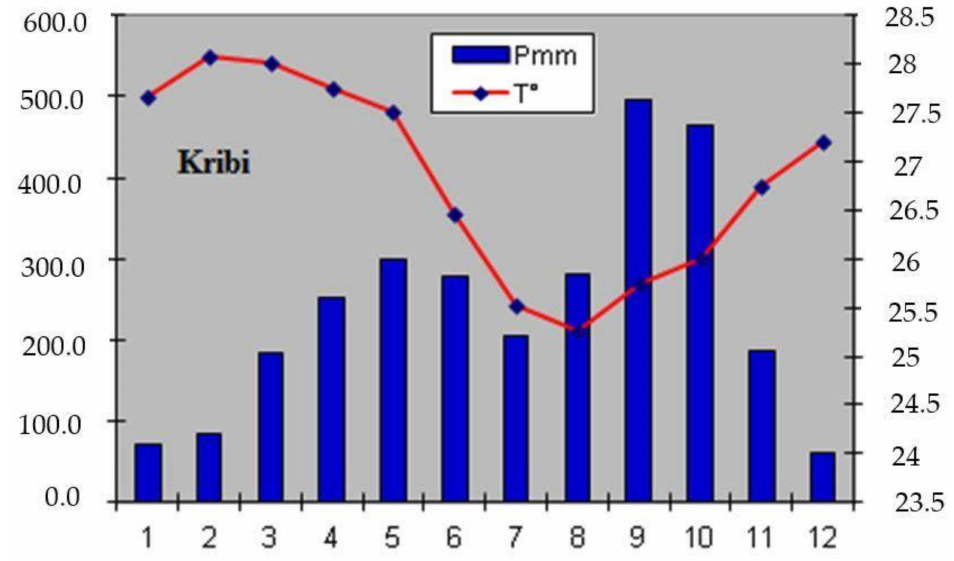
Figure 8. Onbrothermal diagram of